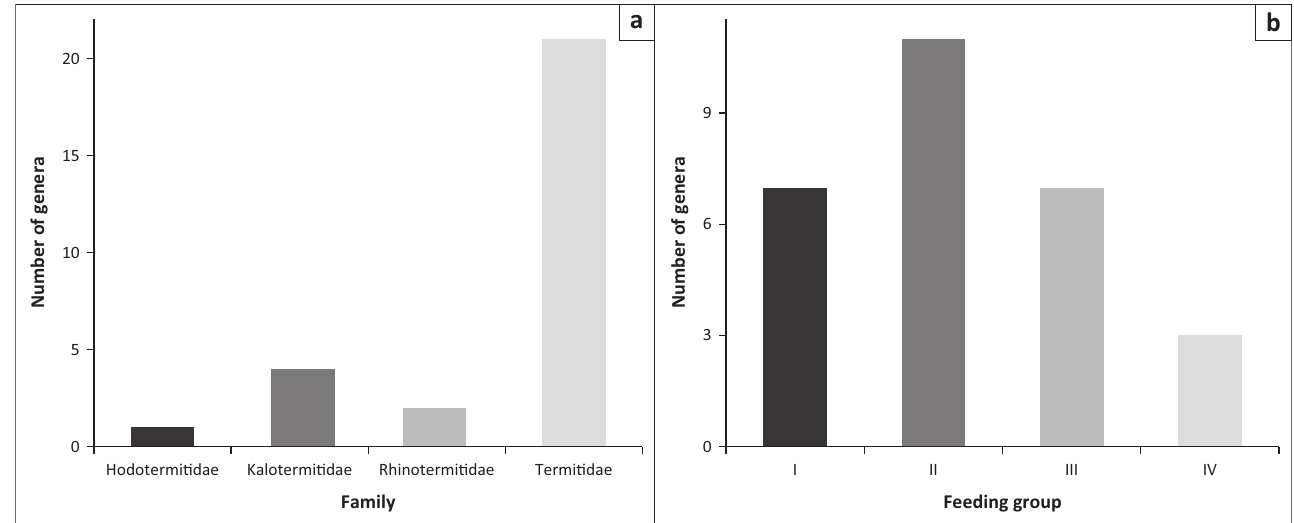
FIGURE 1: Summary of the families (a) and feeding groups (b) of termites sampled in Kruger National Park, South